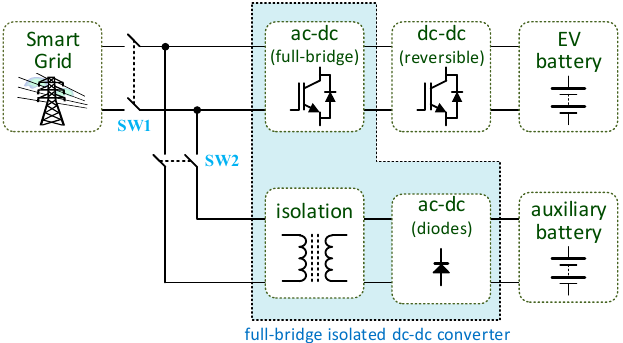
Figure 9. Unified converter topology for charging the EV battery and the auxiliary battery.